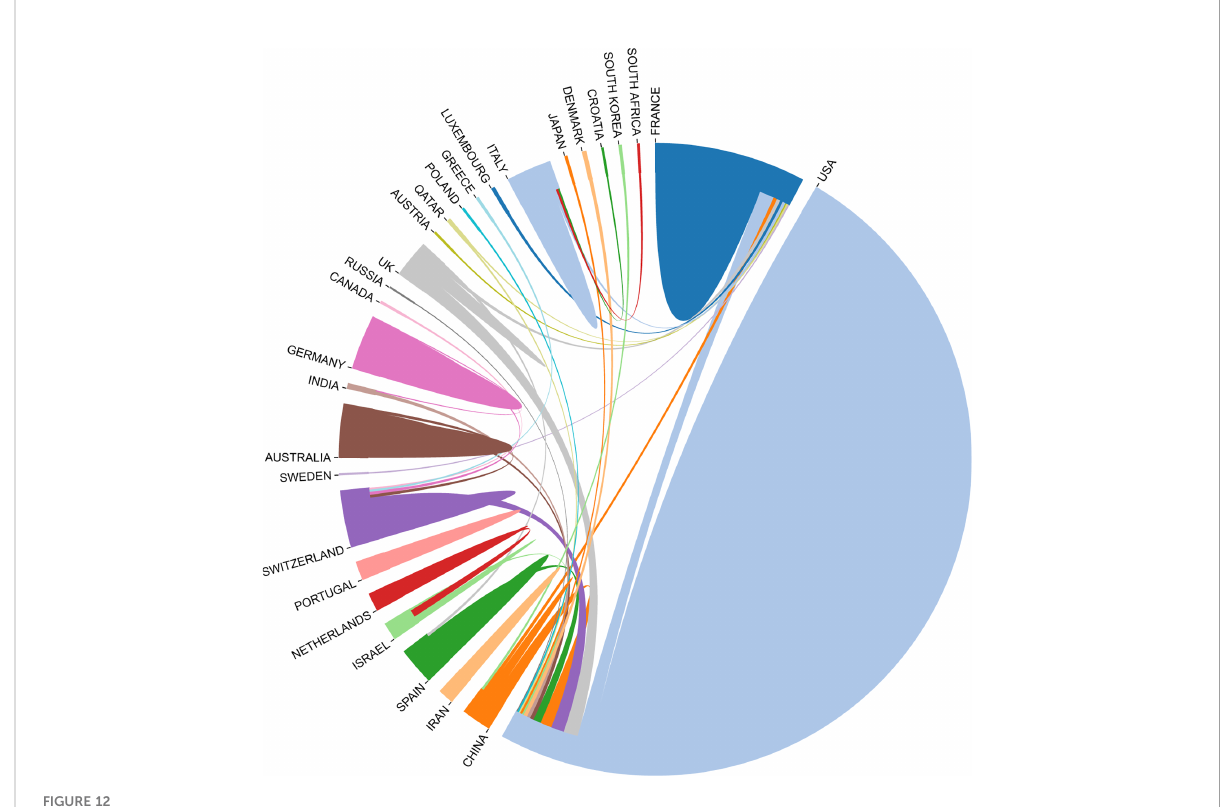
FIGURE 12 Country-to-country relations of top 100 most-cited